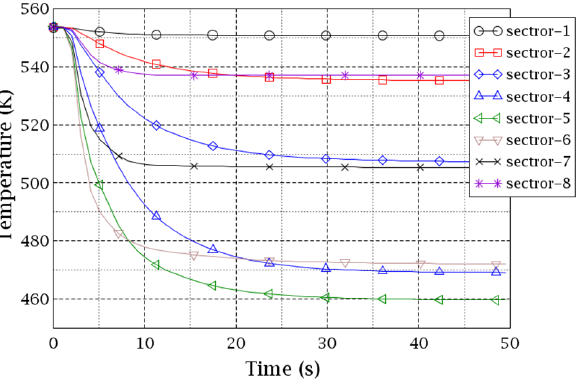
Figure 20. Evolution of the coolant temperature distribution at the core outlet of the AP1000 reactor CY-V (cell index is from Figure 17).